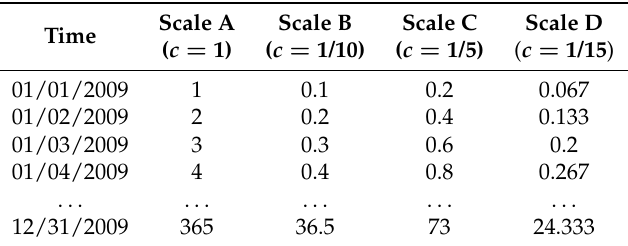
Table 1. Four times scales tested for the PM 2.5 (fine particulate matter) data set.